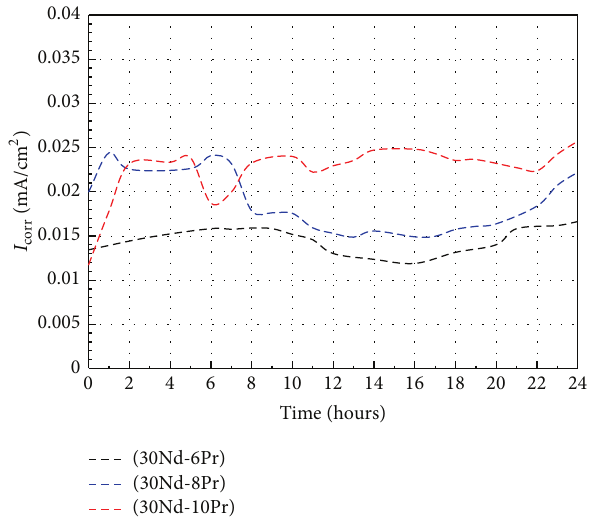
Figure 4: Variation of 𝐸 corr for NdPr magnets tested in 3.5% NaCl solution at 25 ∘ C for 24 hours.